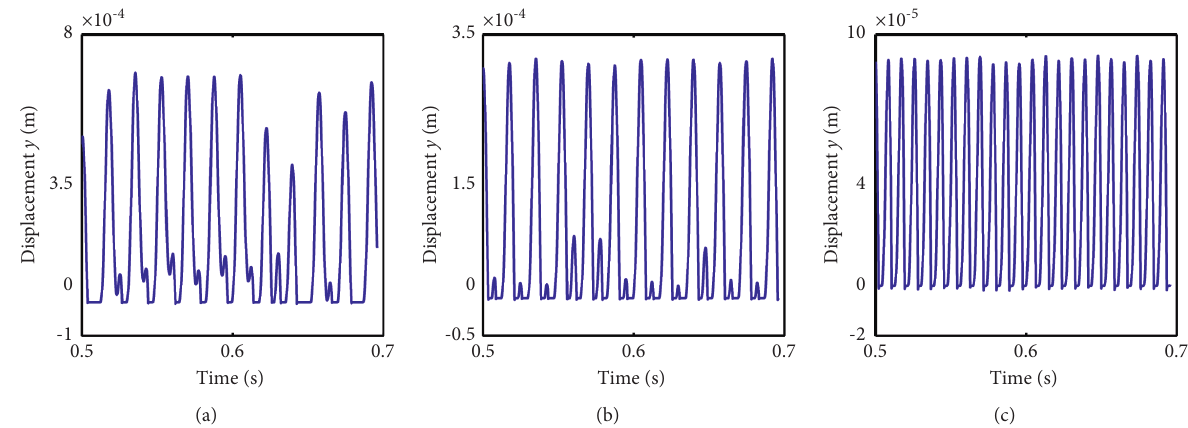
Figure 21: Vibration waveforms of the right bearing support with the change of the mass of the right bearing support. (a) m and (c) m 6 �